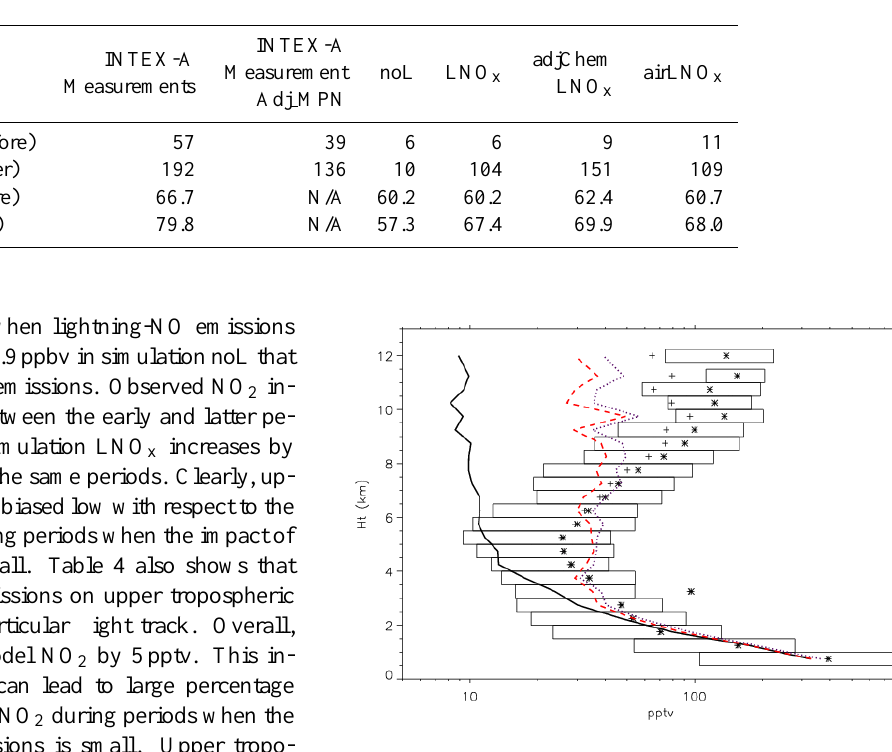
Table 4. Mean upper tropospheric (Pressure < 500hPa) mixing ratios of NO 2 and ozone before and after 02:30p.m.EST for INTEX-A DC-8 Flight 4. Measurements are compared with CMAQ simulations noL, LNO x , adjChemLNO x , and airLNO x . Adj MPN column gives an estimate of NO 2 amounts assuming MPN and HO 2 NO 2 interferences have the temperature dependence shown in Fig. 2 of Browne et al. (2011). Units are pptv for NO 2 and ppbv for ozone.